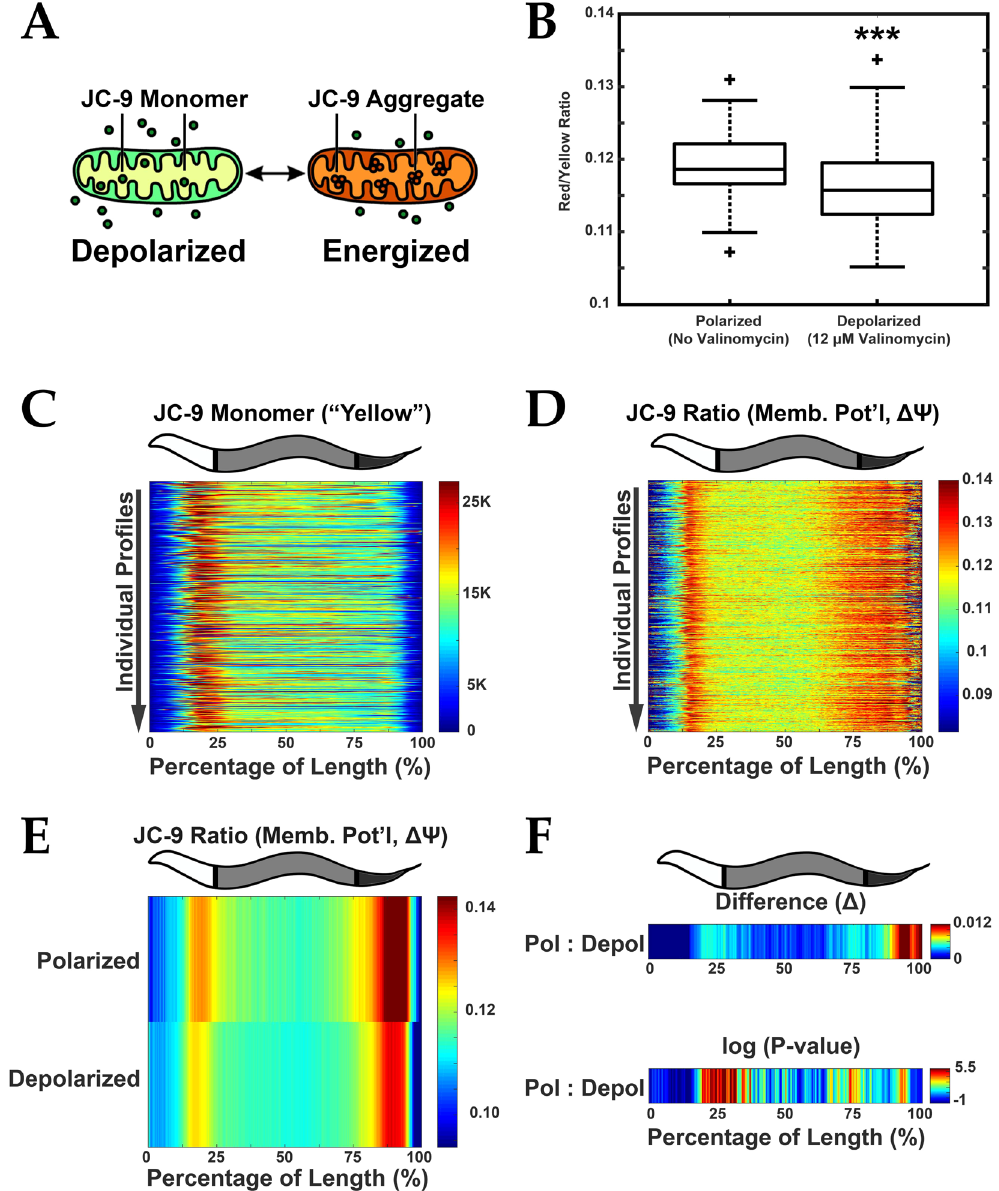
Figure 4. Functional analysis of mitochondrial membrane potential. ( A ) JC-9 is a mitochondrial (Mito) dye that exists in a monomeric (yellow fluorescent) state but forms red fluorescent aggregates when mitochondria are polarized. Red fluorescence increases relative to an increase in mitochondria membrane potential ( Δψ ). The ratio of Aggregate (Red) to Monomer (Yellow) signal thus approximates the magnitude of membrane potential. ( B ) Ratio of Aggregate to Monomer fluorescence decreases upon depolarization with 12 µ M valinomycin indicating a reduction in membrane potential ( Δψ ). *** P < 0.0001. ( C ) Demonstration of orientation algorithm showing individual profiles (Y axis) represented with signal intensity plotted as a function of the animal’s length (X axis). Yellow (monomeric JC-9) fluorescence is shown which enables orientation in young adult C . elegans . ( D ) JC-9 ratio (mitochondrial Δψ ) for these corresponding profiles is also plotted. Data is shown in a heat map with Red as the most signal and Blue the least. ( E ) Median profiles from animals in ( B ) plotting JC-9 (Aggregate/Monomer) ratio when mitochondria are in the polarized and depolarized state. ( F ) Difference ( Δ ) plot (top) and significance plot (bottom) derived from median profiles in ( E ) comparing polarized to depolarized conditions. For significance plots a value ≥ 0 is equivalent to P ≤ 0.05 by Wilcoxon Rank Sum. All animals are positioned with the anterior side to the left. Plots are representative of three biological replicates and derived from n ≥ 50 organisms. Sample size ( n ) and P-values can be found in the Supplementary Table. L.A. Daniele provided the illustrations for Part A originally published in: Daniele, J. R., Heydari, K., Arriaga, E. A. & Dillin, A. Identification and Characterization of Mitochondrial Subtypes in Caenorhabditis elegans via Analysis of Individual Mitochondria by Flow Cytometry. Anal . Chem . 88 , 6309– 6316 (2016) 11